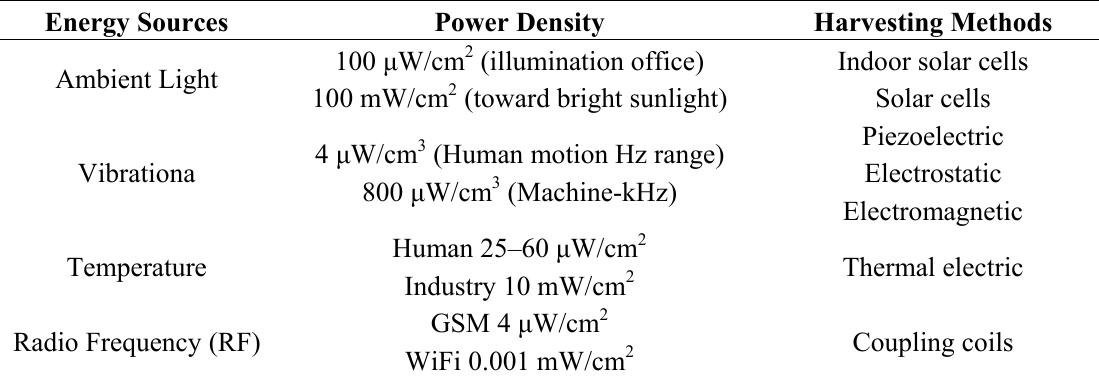
Table 1. Indoor energy sources and harvesting technologies.